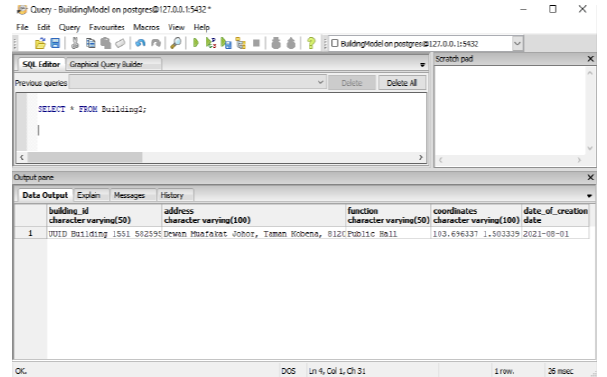
Figure 8. Simple query for CityGML 3D